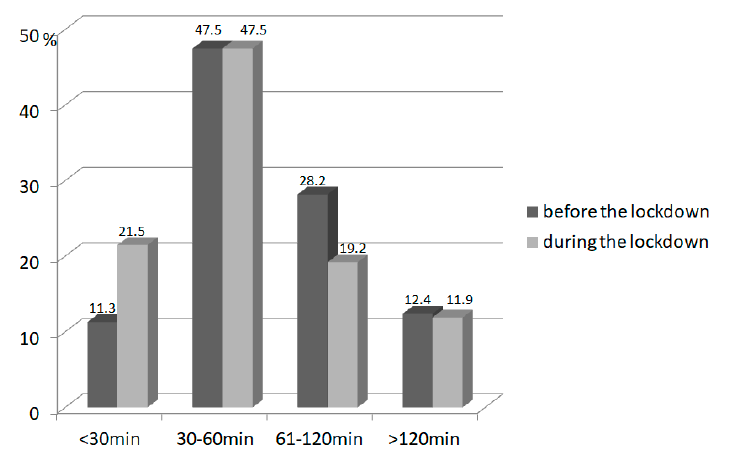
Figure 1. The amount of low physical activity (in minutes per day) in children ( n = 177) before and during the lockdown.